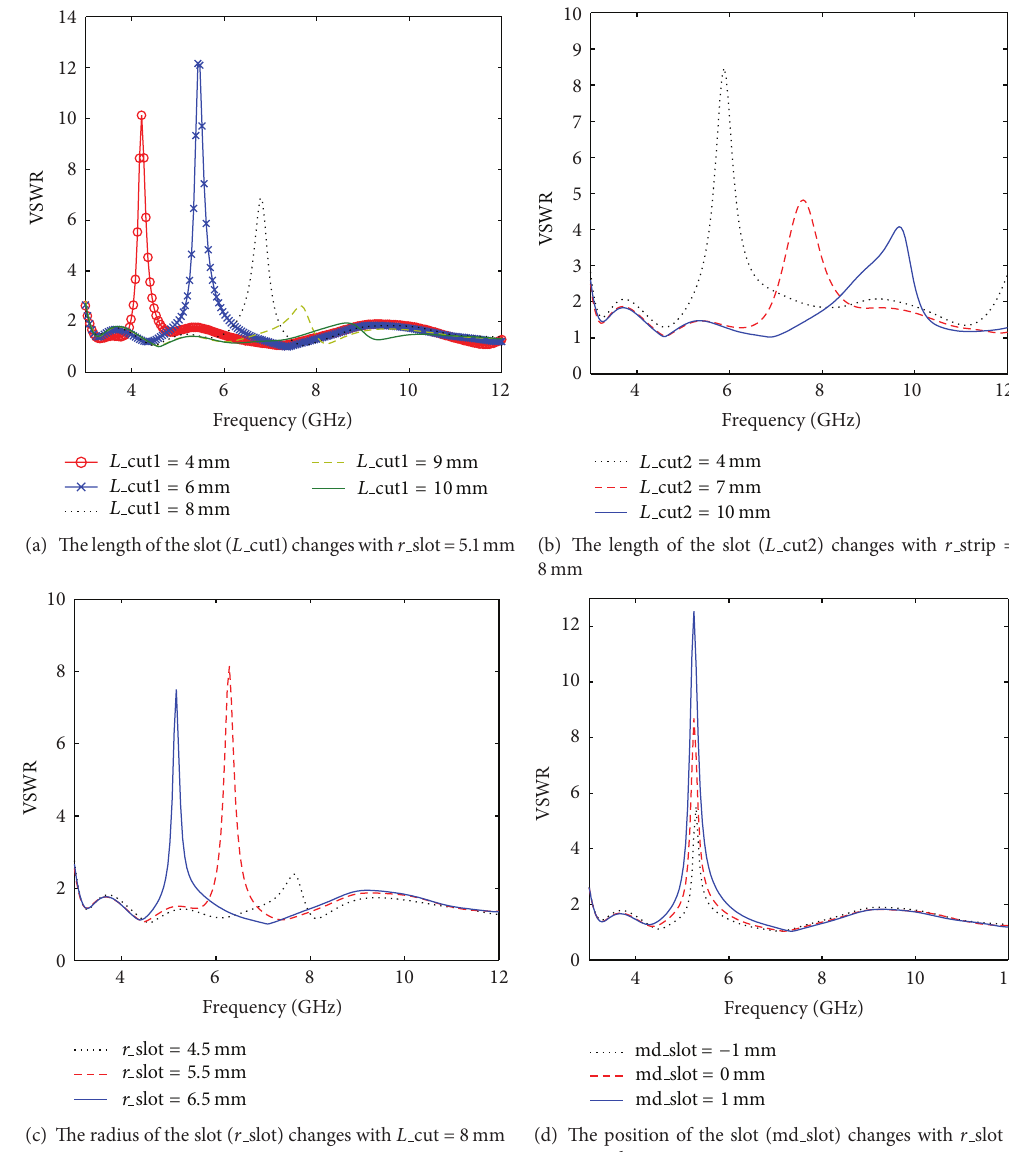
Figure 2: VSWR of the antenna with different lengths of slots and strips ( 𝐶 1 = 13 mm, 𝐶 2 = 8 mm, and 𝑟 𝑤 = 0.5 mm).